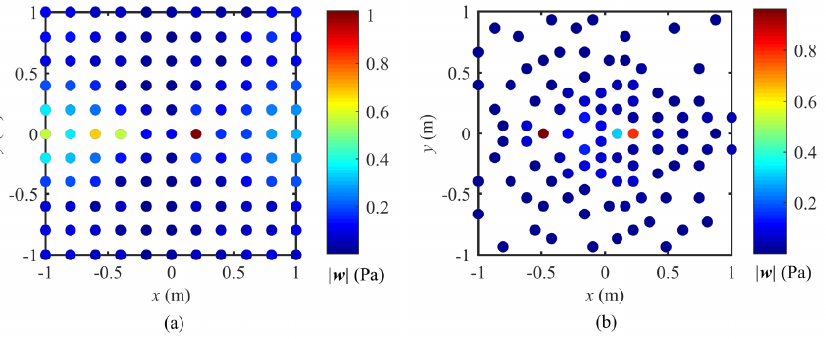
Figure 7. The position and the strength of the equivalent source at 5000 Hz: ( a ) uniform distribution and ( b ) optimum distribution.